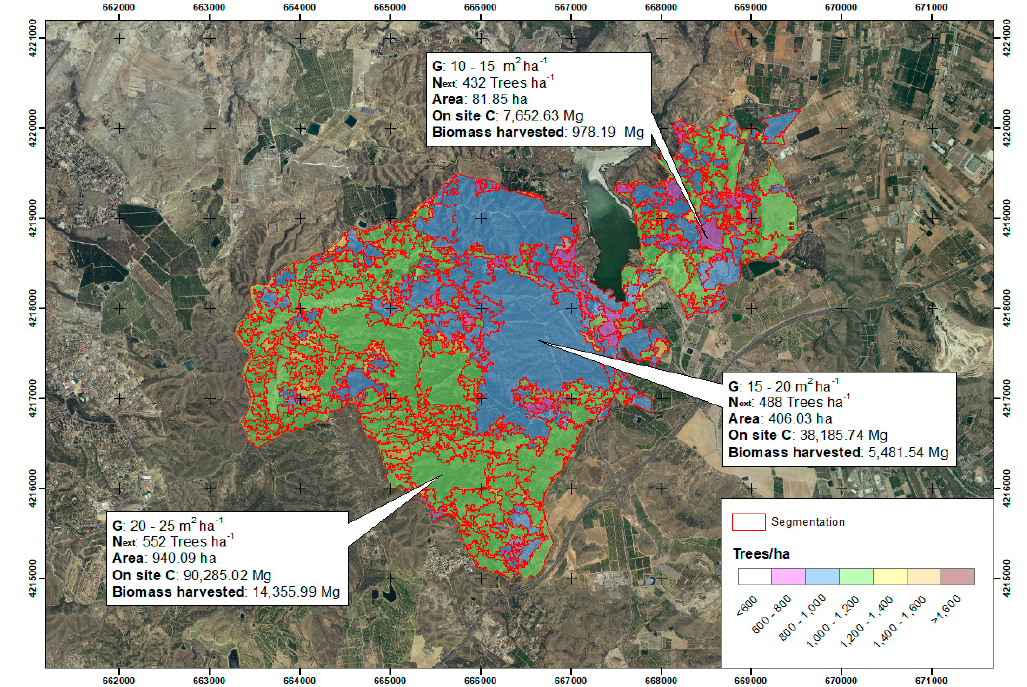
Figure 6. Map of the thinning program obtained using semi-automatic forest stand delineation (Orpheo ToolBox software, OTB) and tree density (D, trees ha − 1 ) at 0.5 pulses m − 2 density ALS data of Pinus halepensis plantations at Los Cuadros (Murcia, Spain).